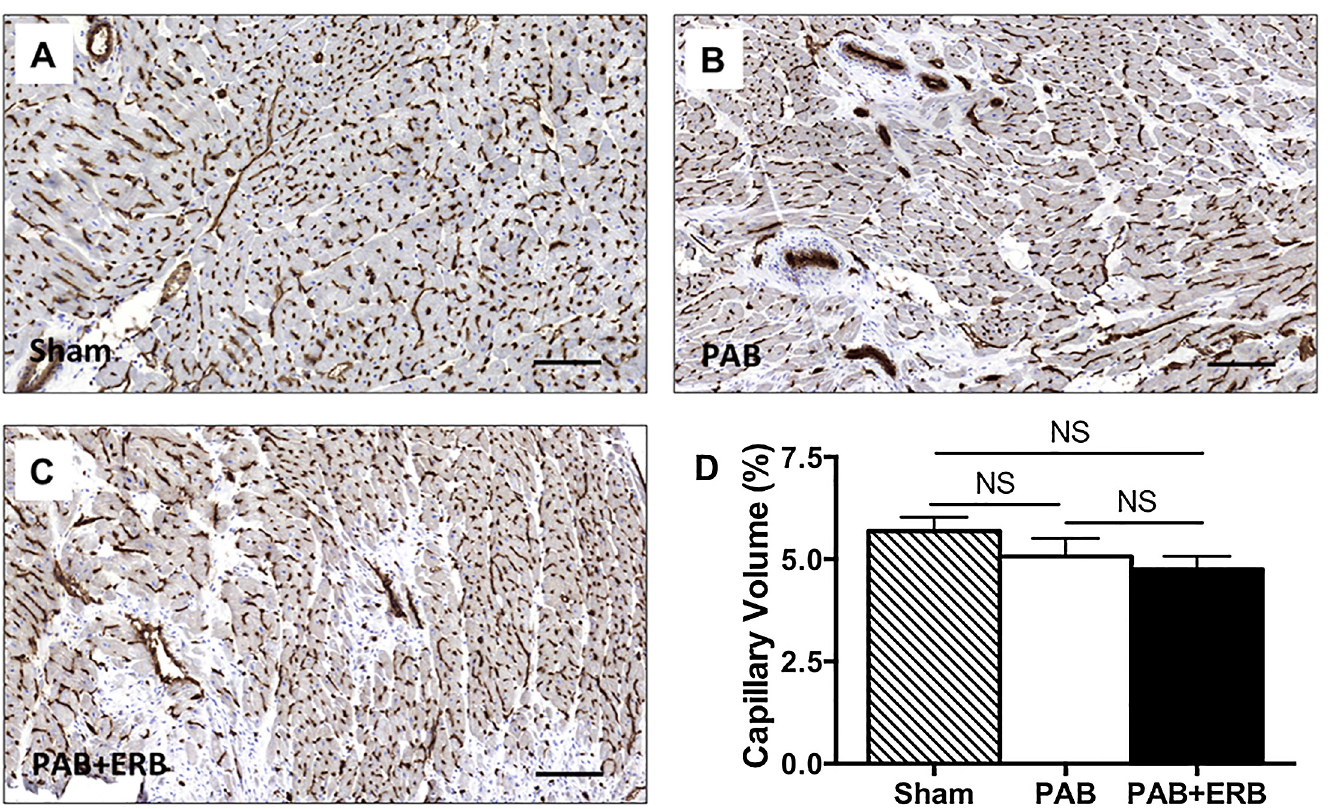
Fig 10. Immunostaining of CD31 represented cardiac vessel volume in sham (A), PAB (B), and PAB+ERB (C) The black lines indicate 100 μ m. D) Quantification of capillary volume (expressed as percentage of tissue volume) shows the PAB group compared to sham, and the PAB+ERB group compared to sham or PAB, did not change. Sham (n = 4), PAB-group (n = 4), and PAB+ERB (n =